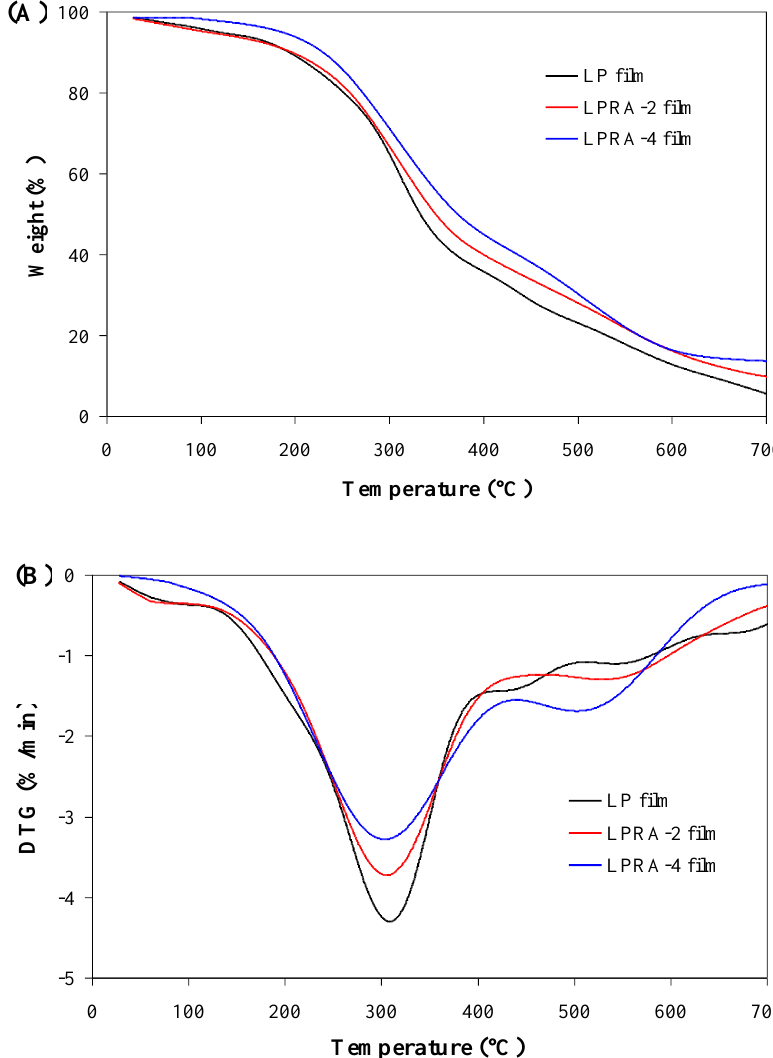
Figure 6. TGA ( A ) and DTG ( B ) curves of LP film, LPRA-2 film, and LPRA-4 film.